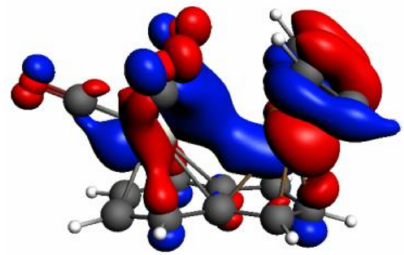
Figure 5. HOMO-3 of syn-Ind-1 ; the isodensity value is